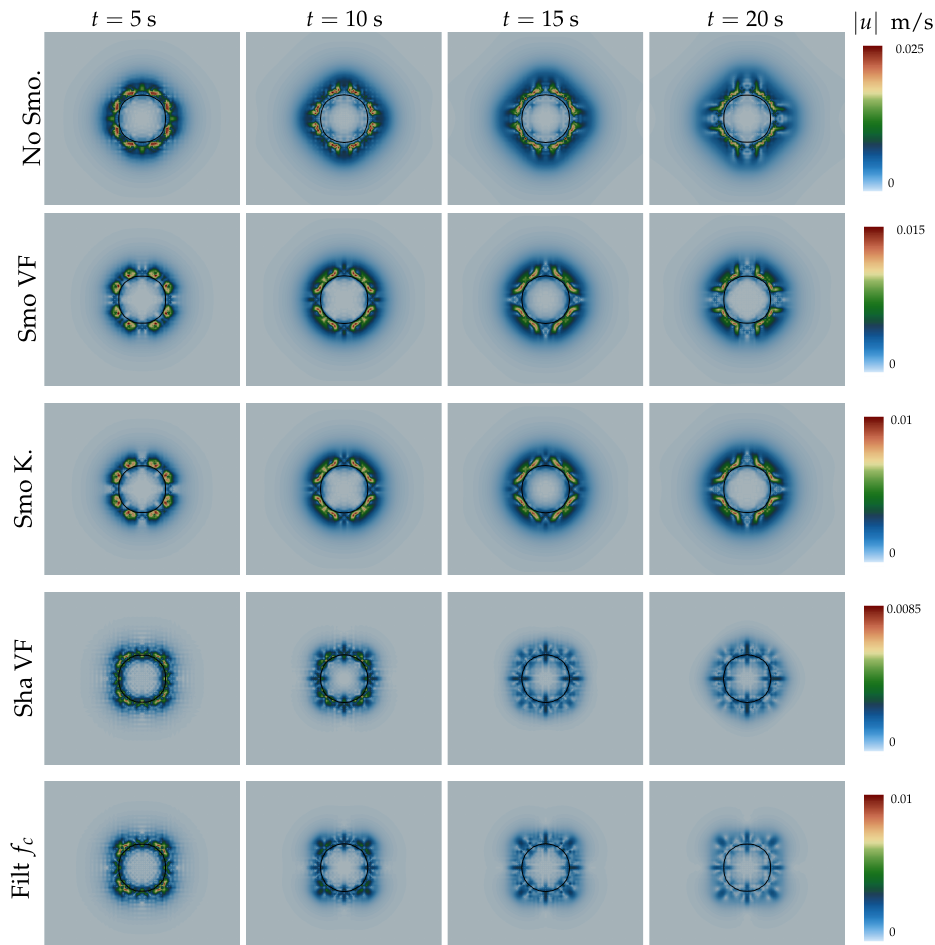
Figure 2. Evolution of the velocity distribution for the different cases. Black line represents the iso-line of α = 0.5. Different rows indicate the different solving